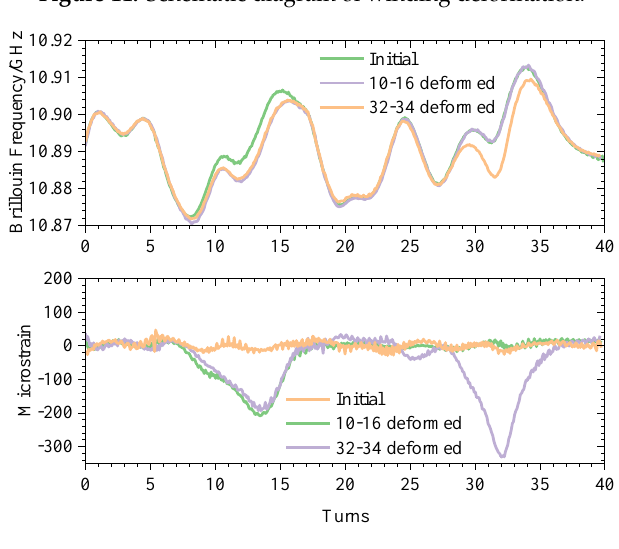
Figure12. BOTDR detection curve Figure 12. BOTDR detection